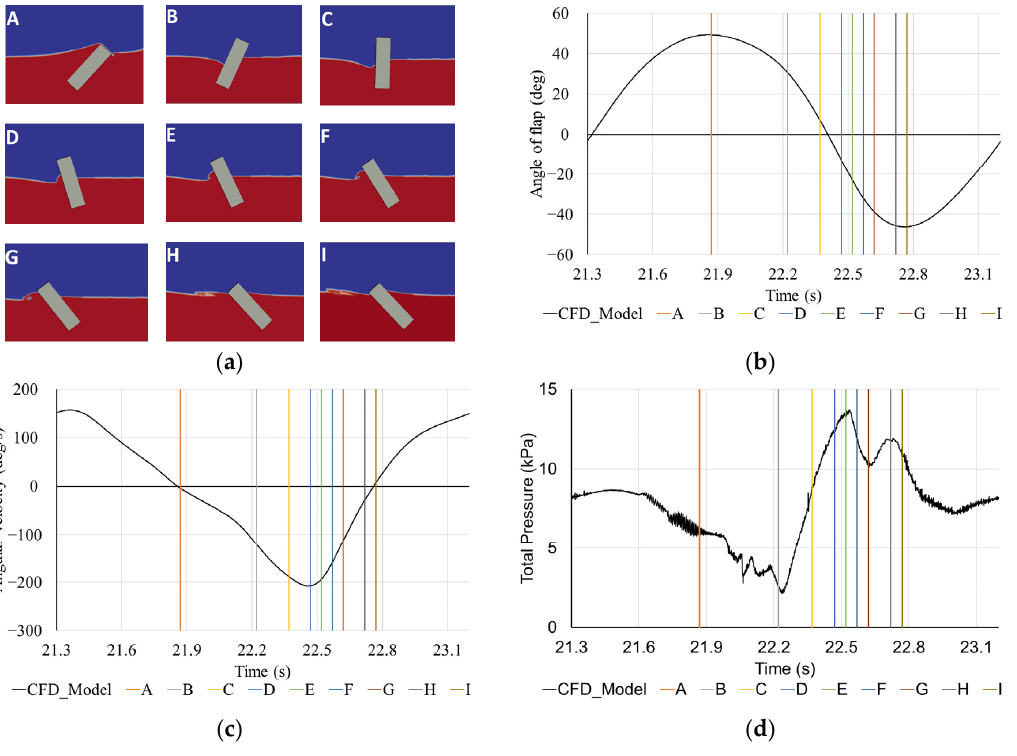
Figure 9. Time series presenting one period of the OWSC movement: ( a ) Motion of the OWSC, ( b ) rotation angle of the OWSC, ( c ) angular velocity, and ( d ) total pressure measured at the contact point between the flap and the free surface in its upright position.